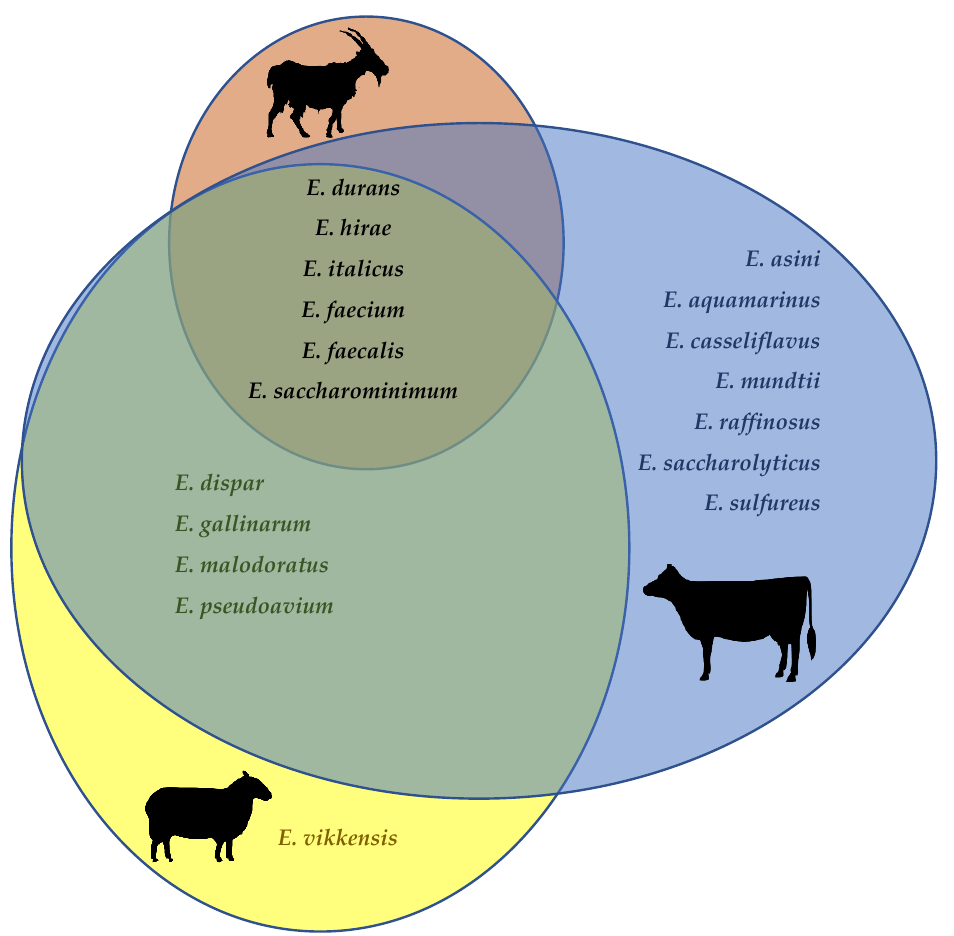
Figure 1. Enterococcal species described to date in raw cow’s, goat’s, and ewe’s milk [31,35,38,39,41,45–64].